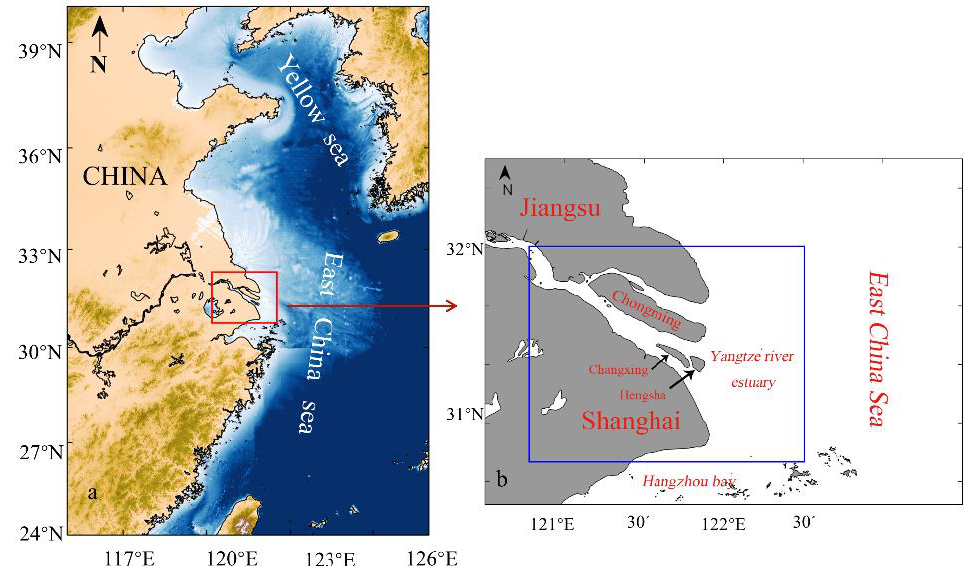
Figure 1. ( a ) Location of Yangtze River. ( b ) Blue square: study area.